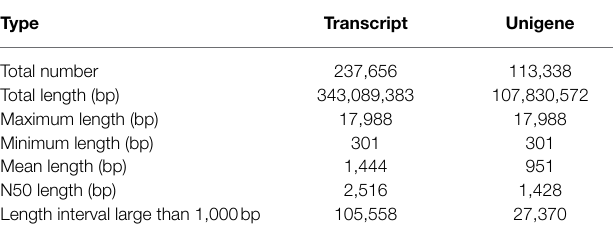
TABLE 1 | Summary of the sequence assembly. TABLE 2 | Statistics of annotations for assembled unigenes in public